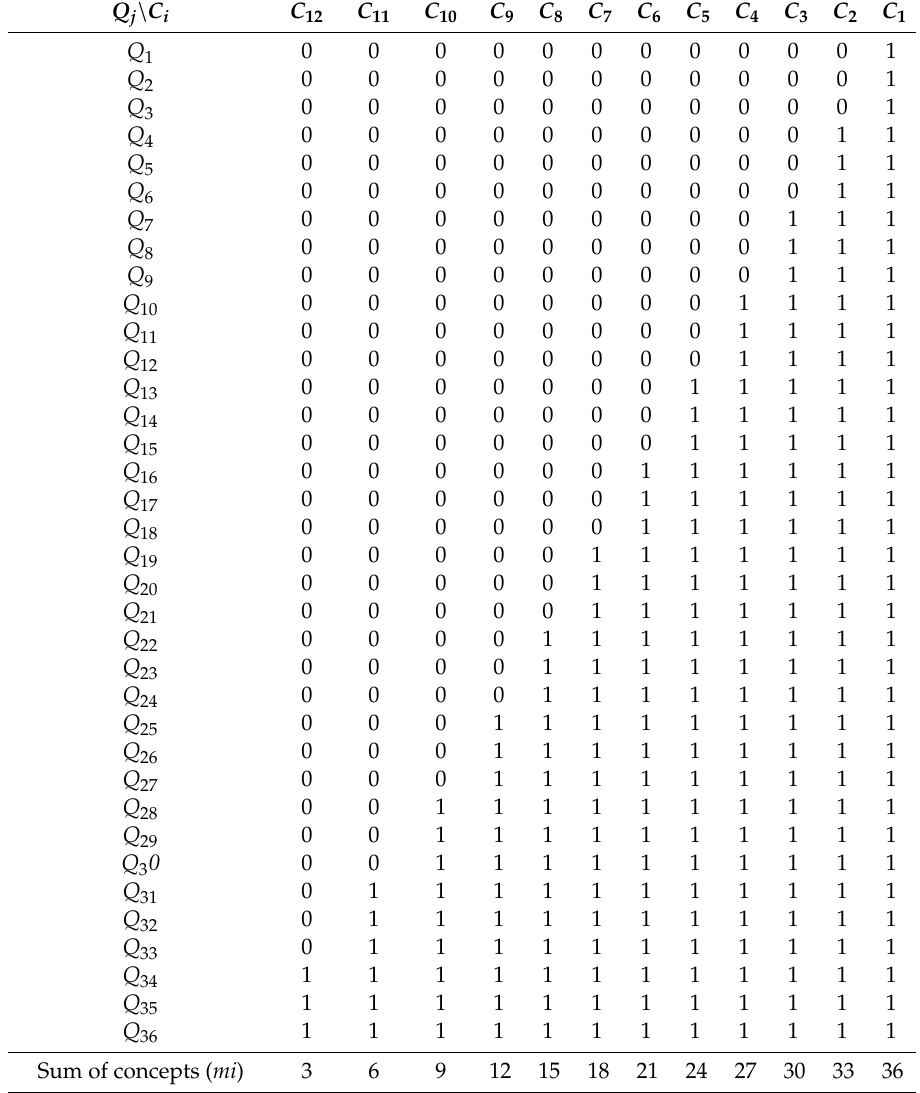
Table 1. Codes for test questions ( Q j ) and concepts ( C i ) in each skill level for the fractions